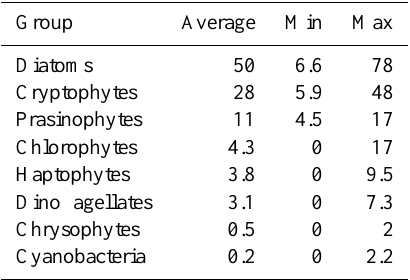
Table 3. Phytoplankton groups contributions to total Chl a esti- mated via CHEMTAX (unit: %).